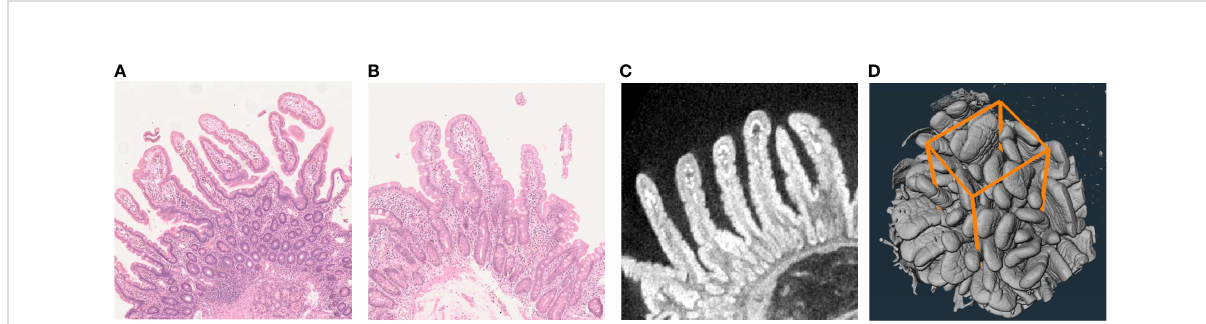
FIGURE 1 Examples of the traditional H&E-stained duodenal biopsy cuttings (A, B) and the corresponding micro-CT cutting (C) obtained from digital 3D reconstruction of up to 1,600 separate CT images (D) . Panel A demonstrates poor sample orientation, visualized by circular cross sections of